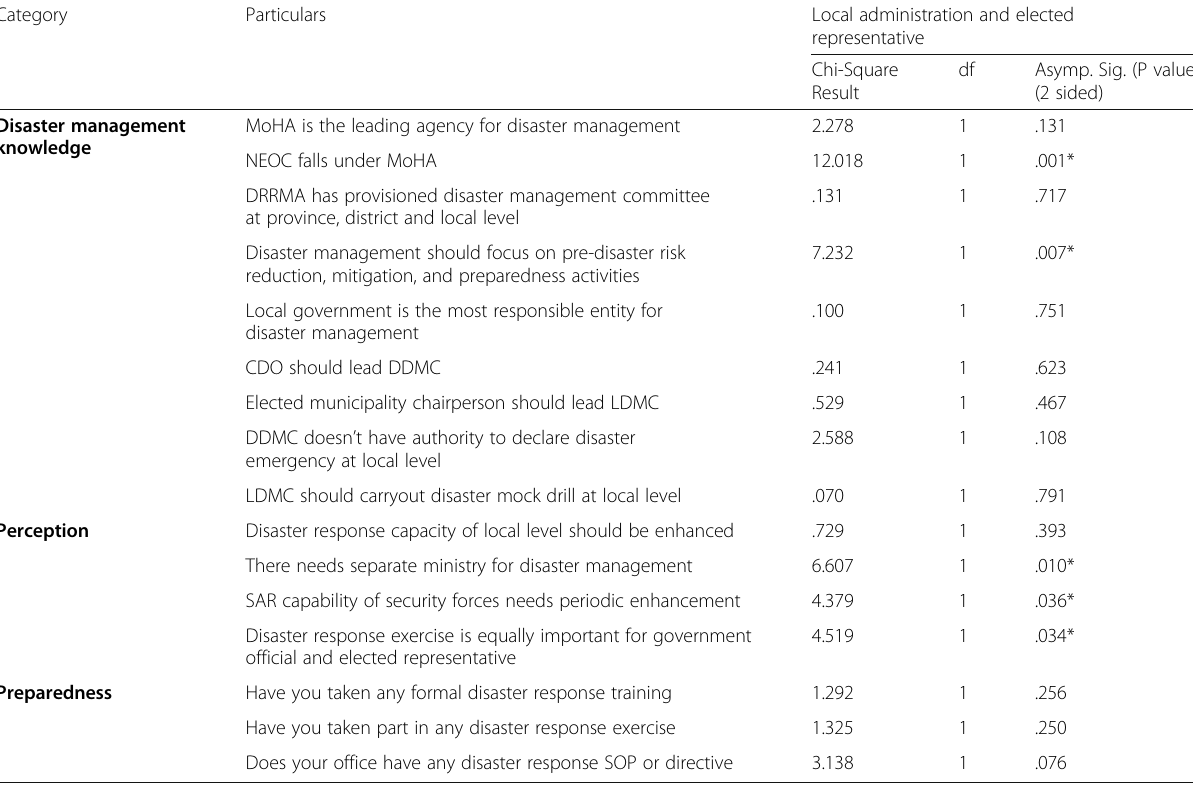
Table 2 Statistical significant difference as per the nature of service